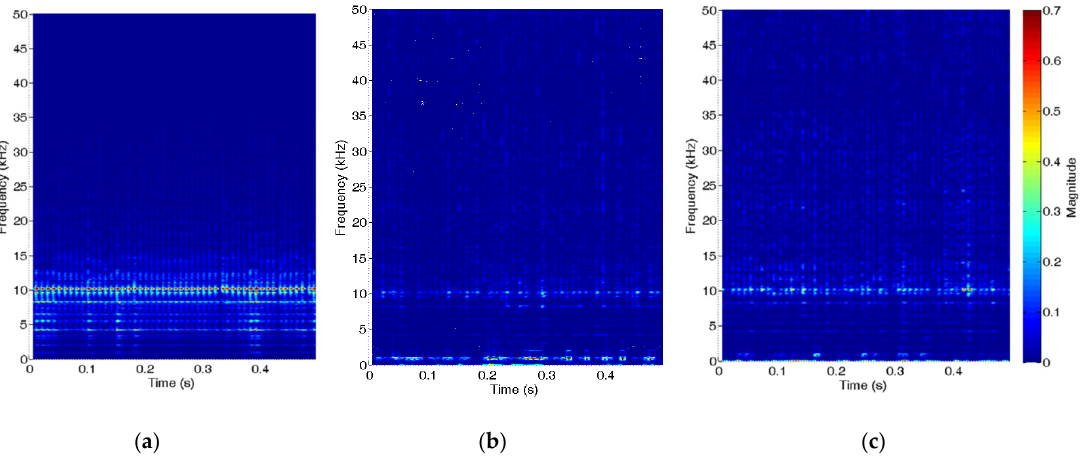
Figure 11. Results of spectrogram from the deep delamination; ( a ) steel ball hammer, ( b ) 11-tooth gear, ( c ) 30-tooth gear.